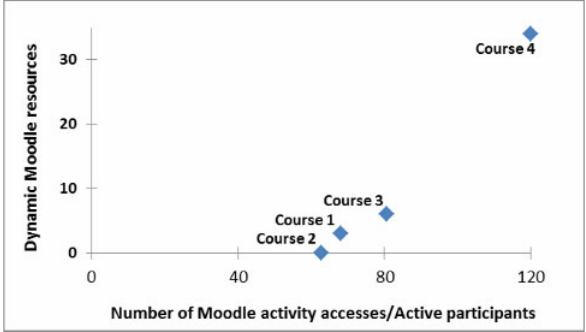
Figure 2. Relation between the number of activity accesses (relatively to the number of active participants) and the number of dynamic re- sources.